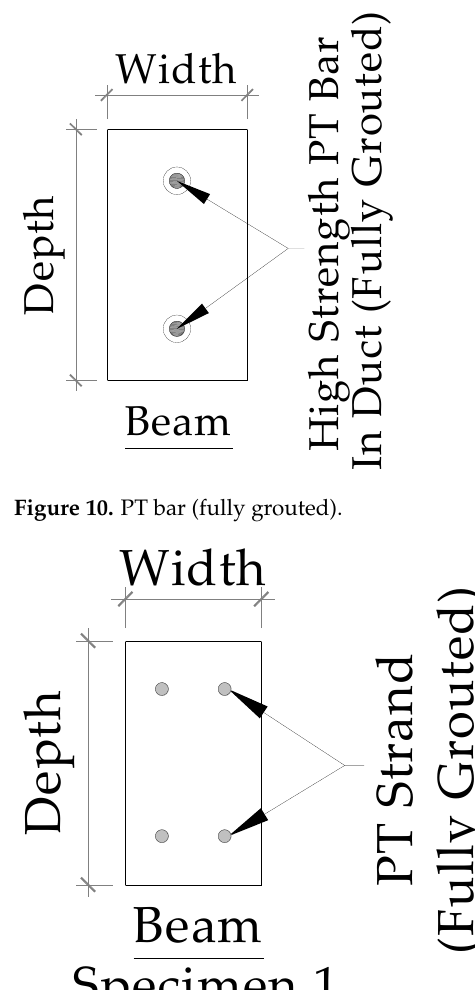
Figure 10. PT bar (fully grouted).